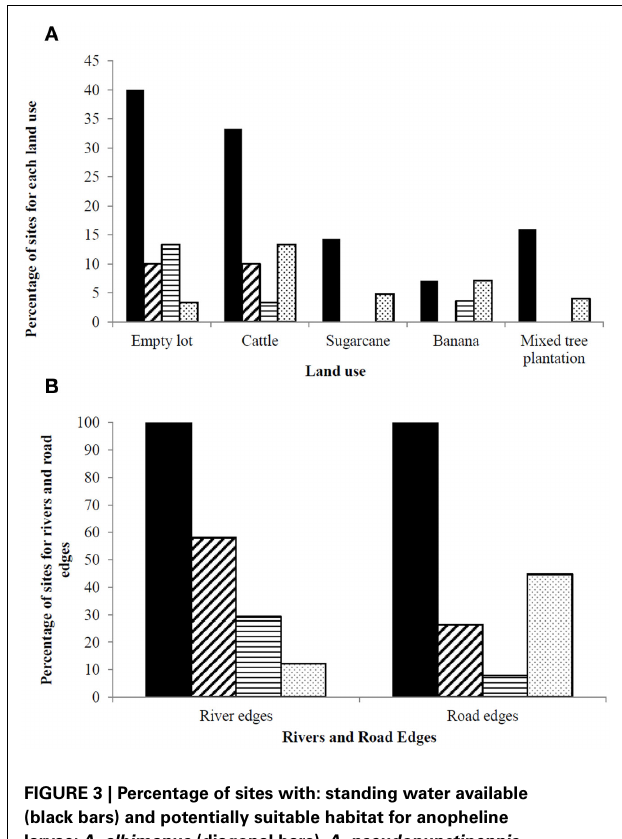
FIGURE 3 | Percentage of sites with: standing water available (black bars) and potentially suitable habitat for anopheline larvae: A. albimanus (diagonal bars), A. pseudopunctipennis (horizontal bars), and A. punctimacula (shaded); for (A) different land uses and (B) river and road edges. Note difference in y-axis ranges between (A) and (B)